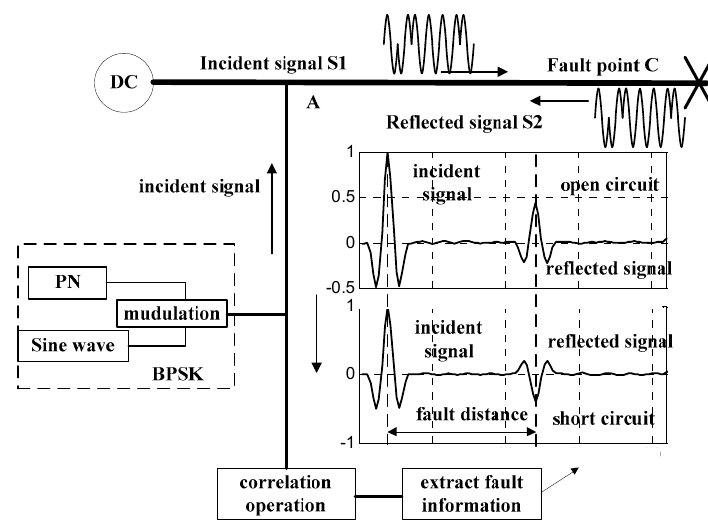
Figure 1. Diagram of Spread Spectrum Time Domain Reflectometry (SSTDR) cable fault diagnosis.